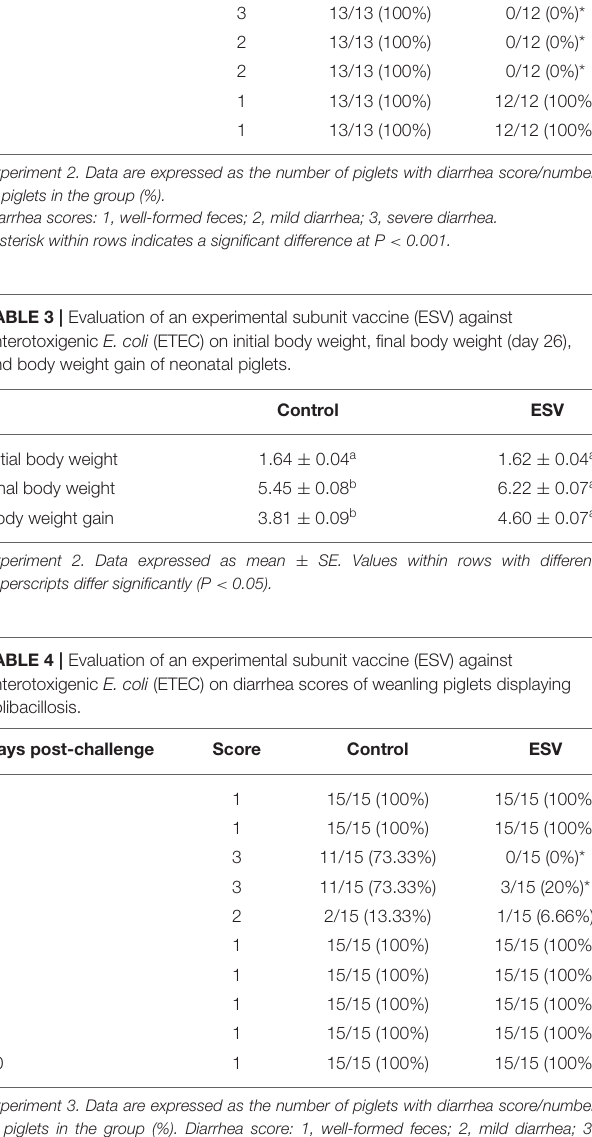
TABLE 2 | Evaluation of an experimental subunit vaccine (ESV) orally administered (Biotech Vac E. coli ) against enterotoxigenic E. coli (ETEC) on diarrhea scores of neonatal piglets displaying colibacillosis.